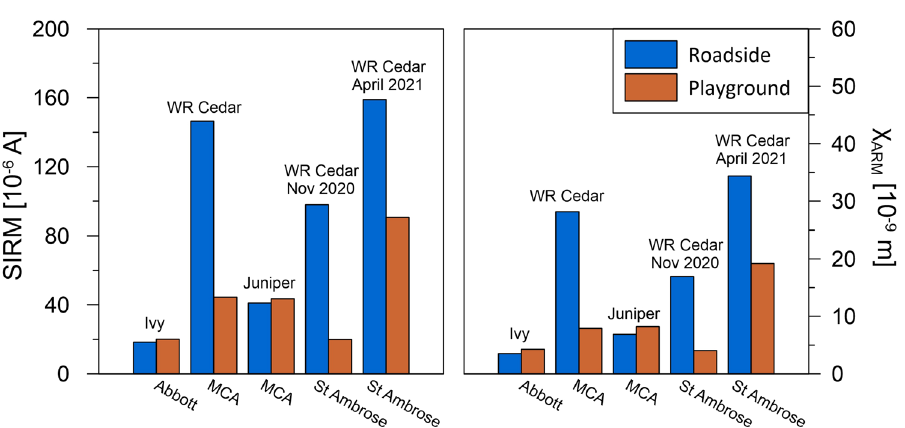
Figure 4. Surface area-specific saturation remanent magnetisation (SIRM) and susceptibility of anhysteretic remanent magnetisation ( χ ARM ) of leaf samples taken from the roadside and playground sides of the